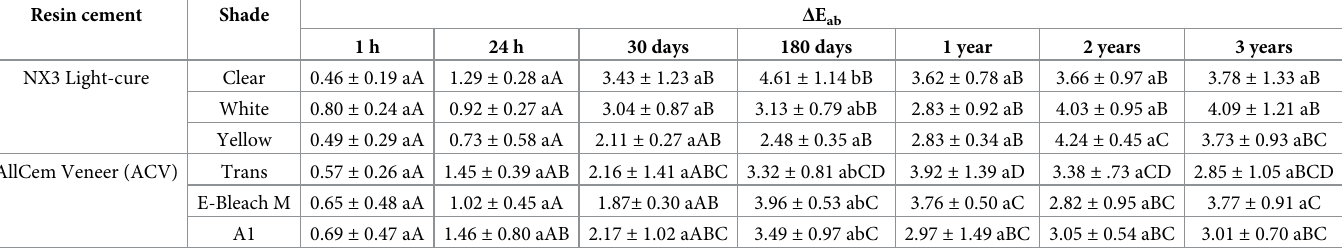
In each row, values followed by the same capital letters are statistically similar (p > 0.05). In each column, values followed by the same lowercase letters are statistically similar (p >